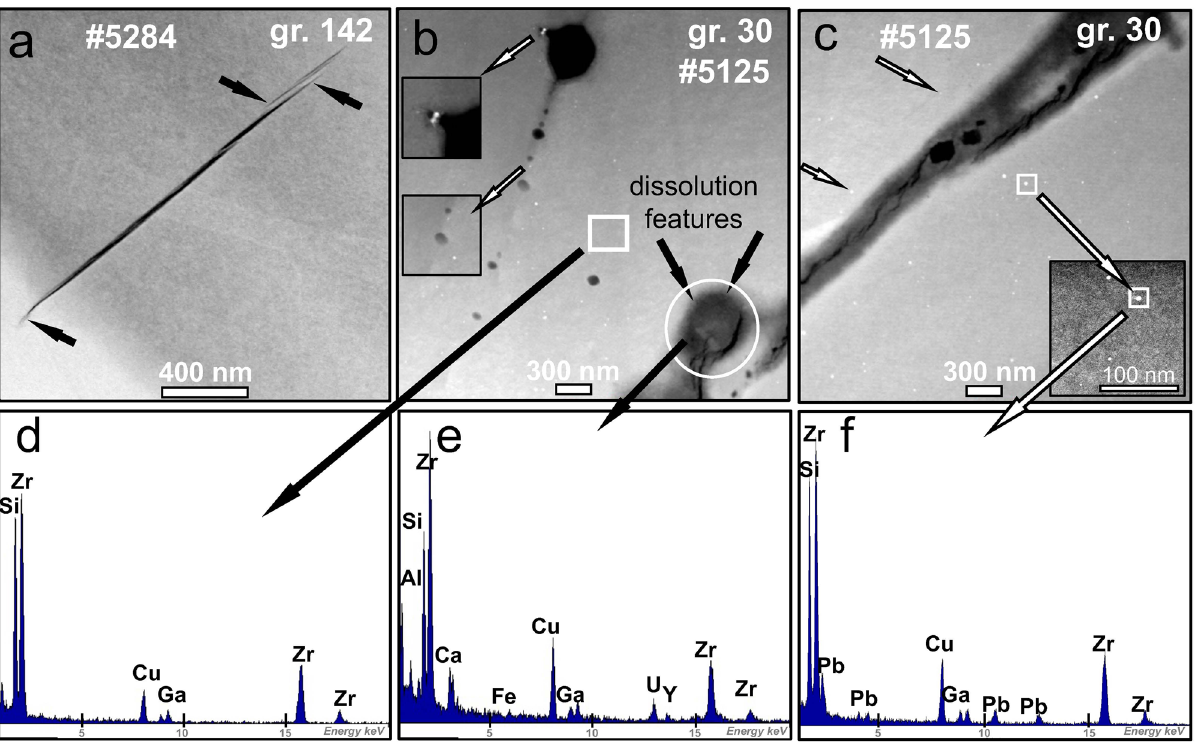
Figure 3. HAADF Z-contrast TEM images of zircon containing cracks and pores. ( a ) Example of sharply defined crack in foil #5284 from grain 142 of Group 2 ; note the pointed terminations marked by black arrows. There are no Pb nanospheres in this group; ( b ) pores (grey/black) along trails of healed cracks in foil #5125 from grain 30 of Group 5 . White arrows pointing to insets highlight relationship between Pb nanospheres and the healed crack and pores in the top-left of the image; dissolution features are evident around the pore in the bottom right corner of the image (within white circle). The white square and white circle refer to panels ( d,e) , respectively; ( c ) in the same foil as ( b ), a healed crack with blurred margin contains pores (black) and is in close proximity to Pb nanospheres (two identified by small white arrows). Large white arrows identify a Pb nanosphere that is enlarged in the inset and linked to the image in ( f) ; ( d–f ) EDS spectra of areas marked in ( b,c) and selected to show the composition of ( d ) an area of zircon matrix; ( e ) a crack with a pore; and ( f ) a